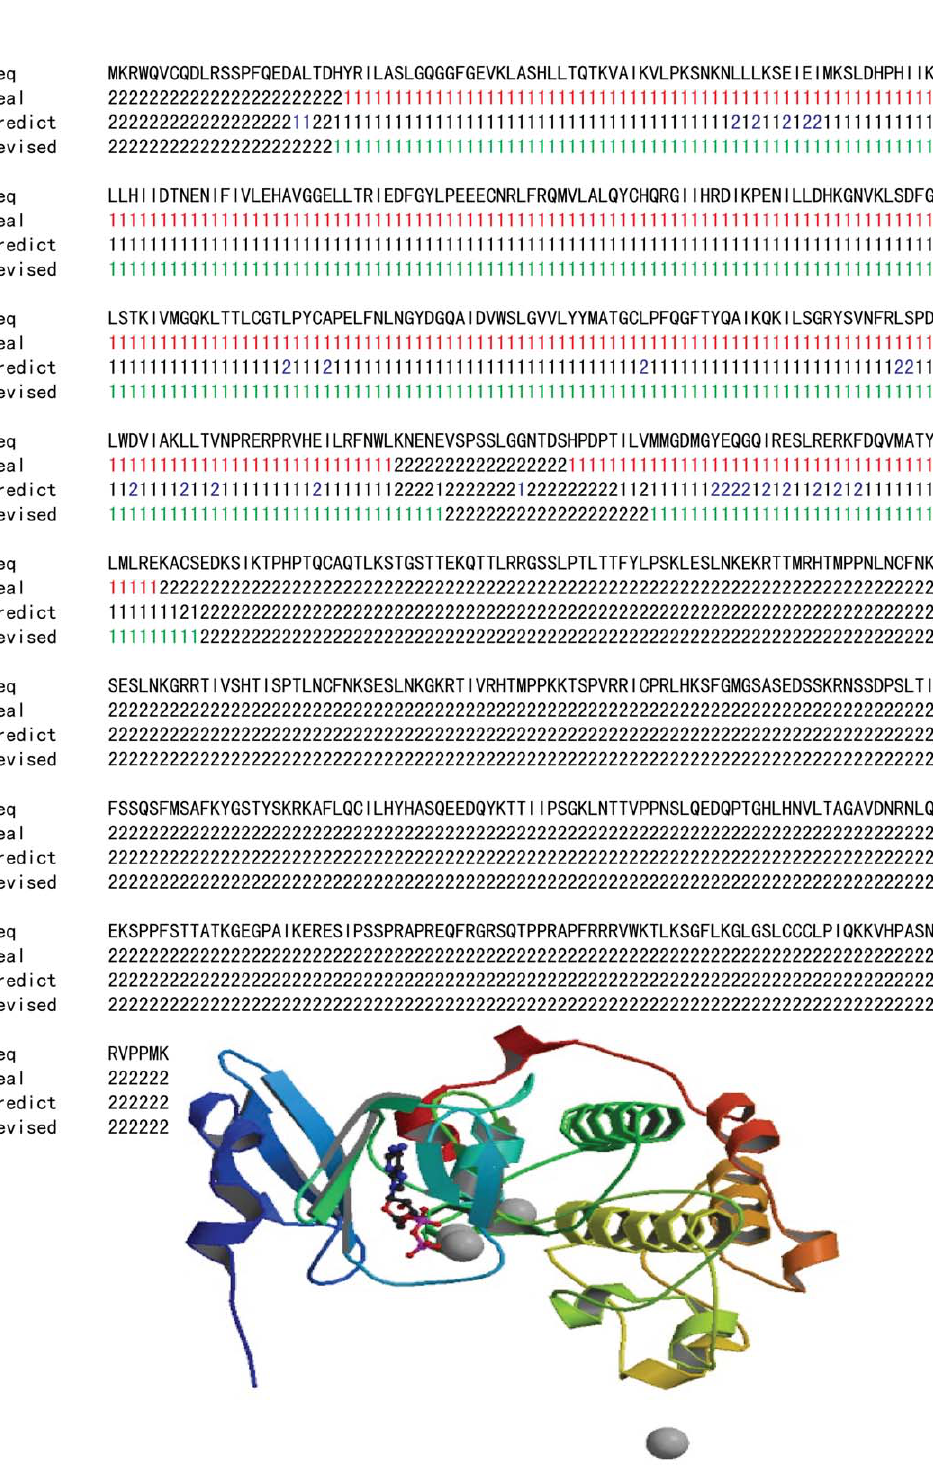
Figure 7. Illustration to show the predicted results obtained before and after applying the sequence-scanning refinement operation. A residue assigned to the domain region was coded with ‘‘1’’; otherwise, ‘‘2’’. The 3D structure of A1A5Q6 was retrieved from ModBase. See the text for further explanation.